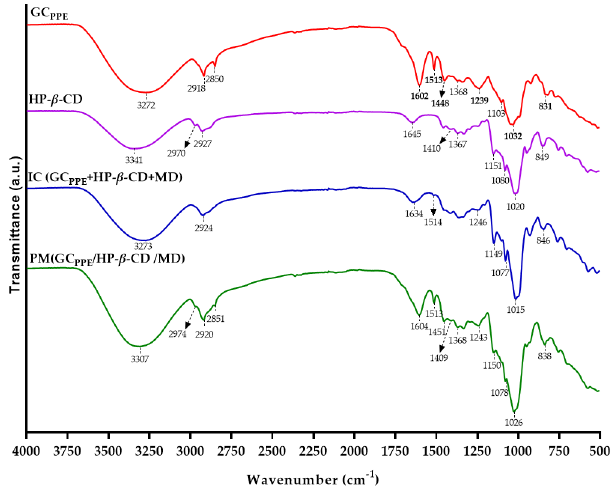
Figure 2. FTIR-ATR spectra of the GC PPE ( red ), HP- β - CD ( purple ), IC (GC PPE +HP- β -CD+MD) ( blue ), and PM (GC PPE /HP- β -CD/MD) ( green